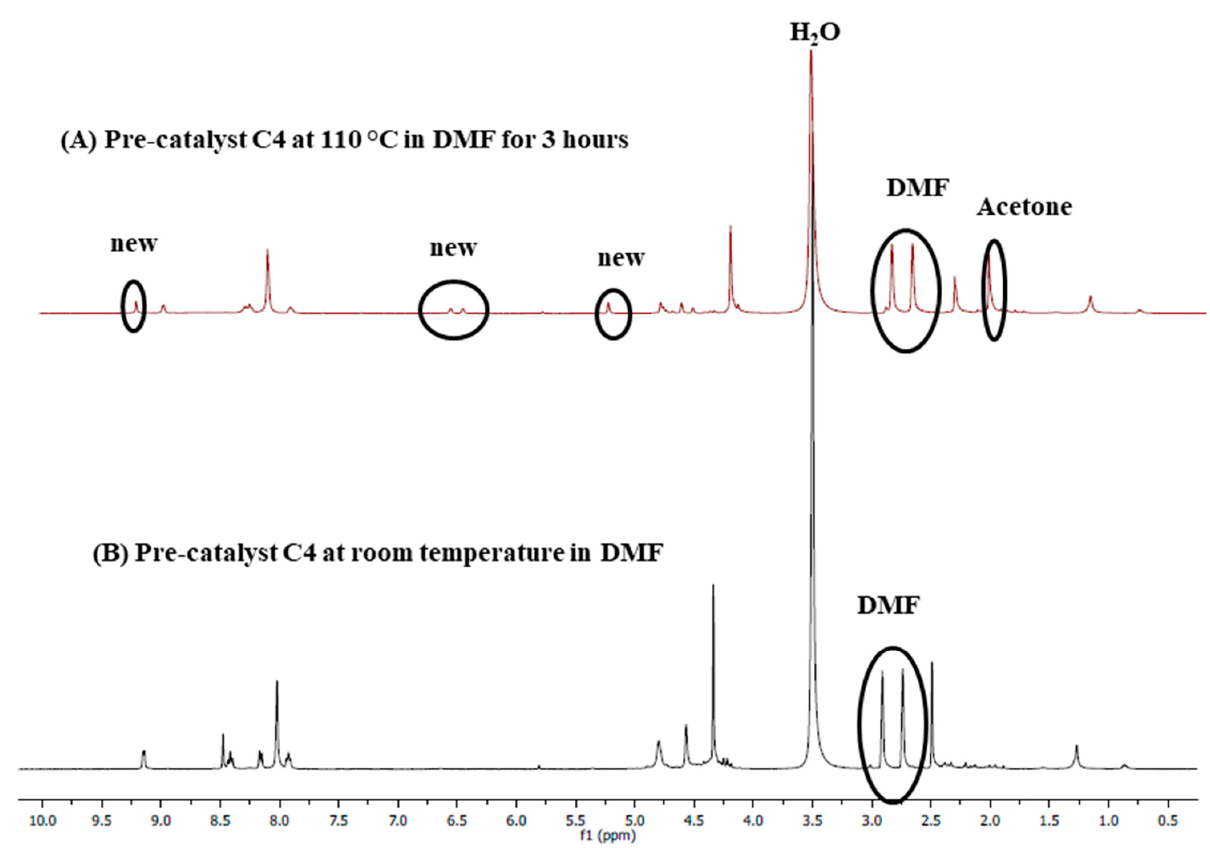
◦ C for 3 h. ( B ) at room